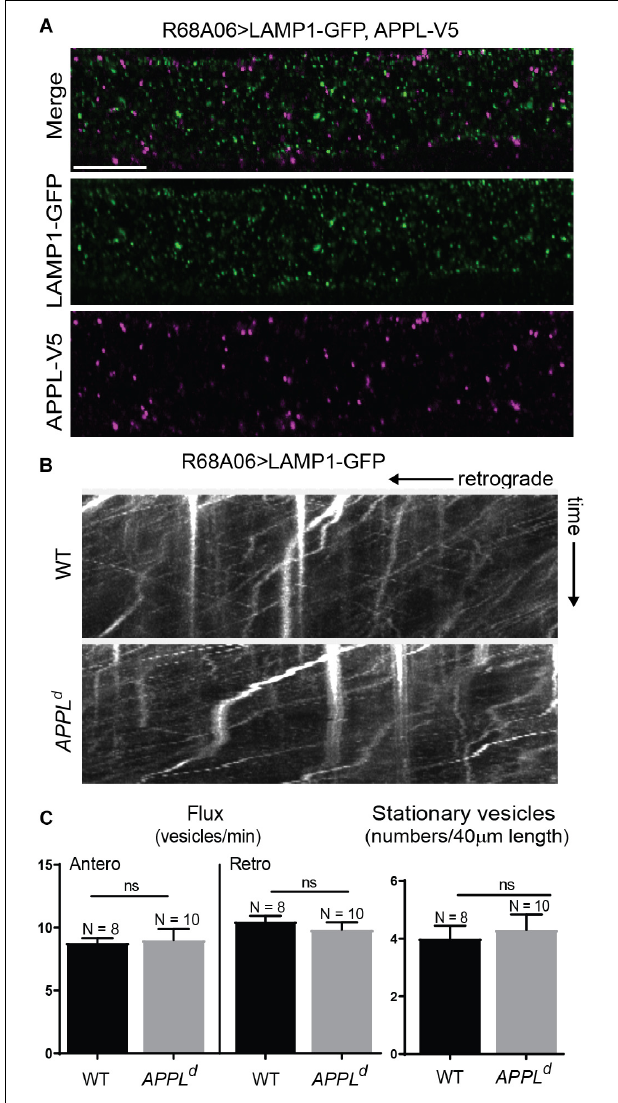
FIGURE 3 | LAMP1 axonal trafficking in APPL loss of function mutants. (A) Immunolabeling of GFP- tagged LAMP1 (green) and V5-tagged APPL (magenta) in adult GF axons co-expressed using the R68A06 Gal4-driver. Single confocal slices of the different channels in the same plane are shown separately and together. No co-localization was observed. Scale bar represents 10 µ m. (B) Kymographs (unbleached) of axonal transport of LAMP1-GFP vesicles in wildtype (WT) control animals and APPL d null mutants ( Supplementary Videos S6, S7 ). Videos were obtained at two frames per second. (C) Quantification of LAMP1-GFP vesicle trafficking in wildtype and APPL d mutants. Numbers of stationary vesicles, and numbers of vesicles moving in anterograde and retrograde direction (Flux) were analyzed. N indicates numbers of axons assessed. Error bars represents standard error mean. Statistical significance between genotypes was assessed using Student’s t -test (ns, non-significant, p >